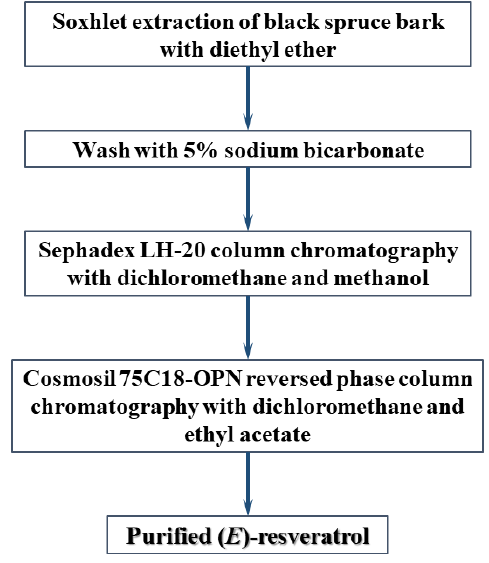
Figure 4. Flowchart of the purification procedure.